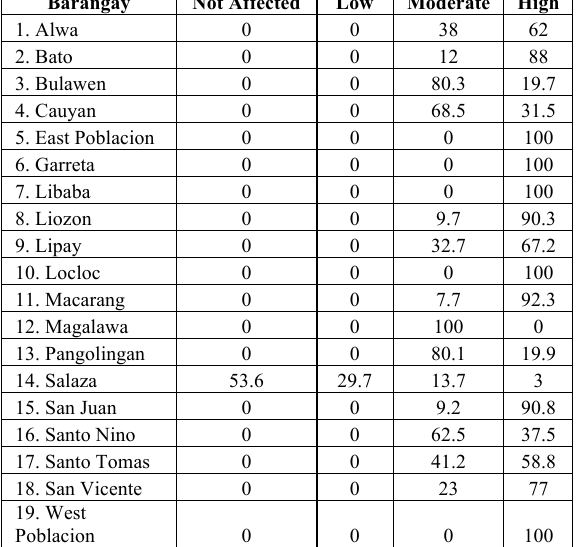
Table 10. Percentage of area affected by flood in Palauig